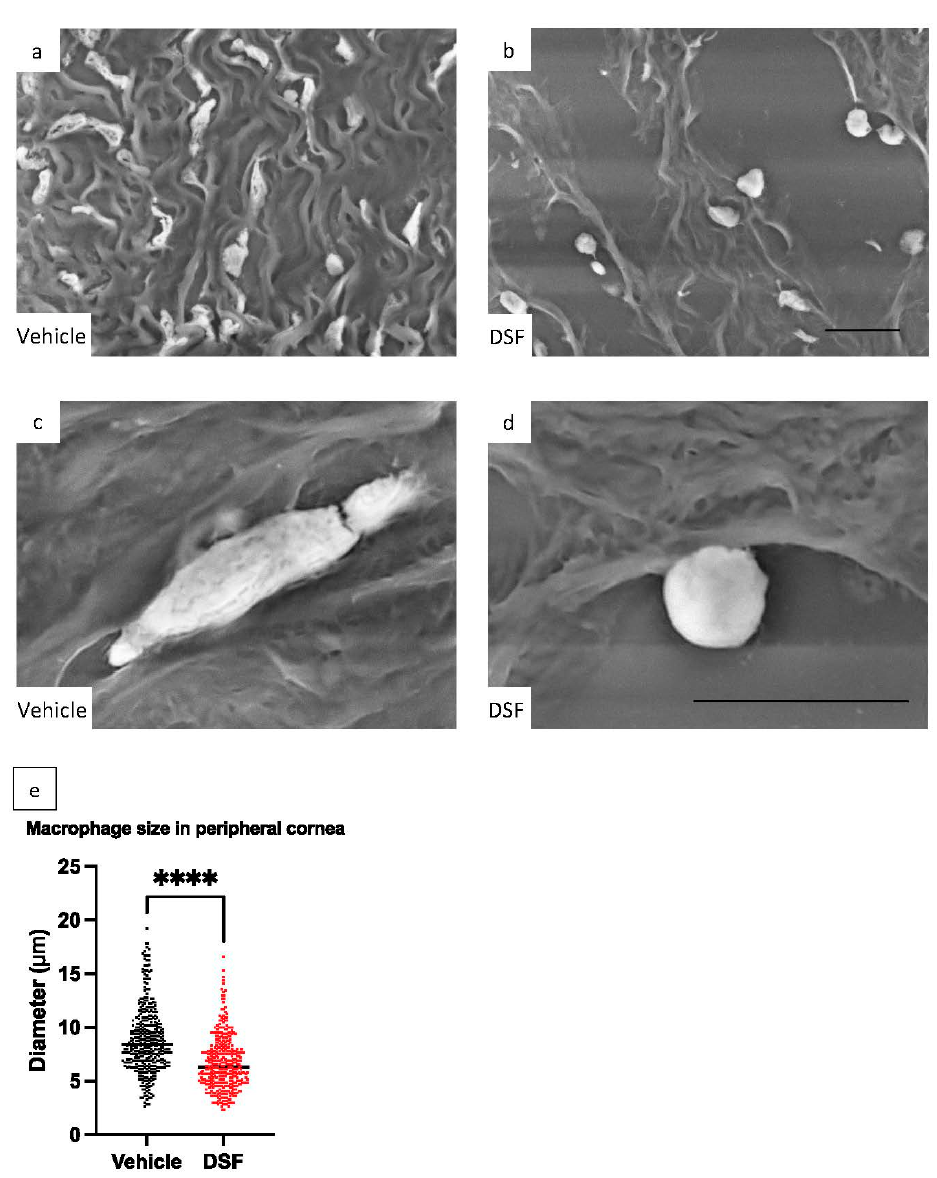
Figure 7. To evaluate pseudopodia formation of macrophages infiltrating the peripheral cornea in the Vehicle group ( a , c ) and DSF group ( b , d ), the length of ED-1-positive cells was evaluated in rat corneas using LV-SEM 1 d after alkali burn. Images ( a , b ) were taken at 2000 × . Bar, 10 μ m. Images ( c , d ) were taken at 8000 × . Bar, 10 μ m. The length of macrophages was measured. The length of 392 ED-1-positive cells from 11 eyes that had infiltrated the peripheral cornea in both groups was measured and compared ( e ). Data are shown as mean ± standard error ( n = 392 samples/group). **** p < 0.0001.